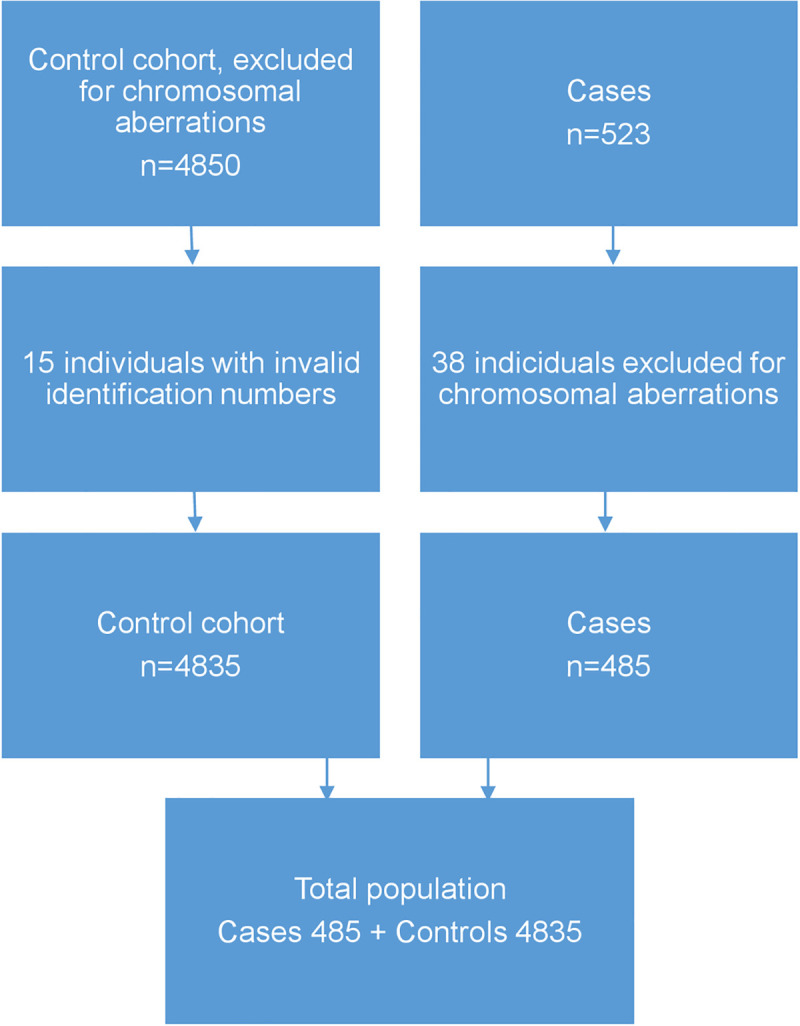
Flow diagram of the study population.